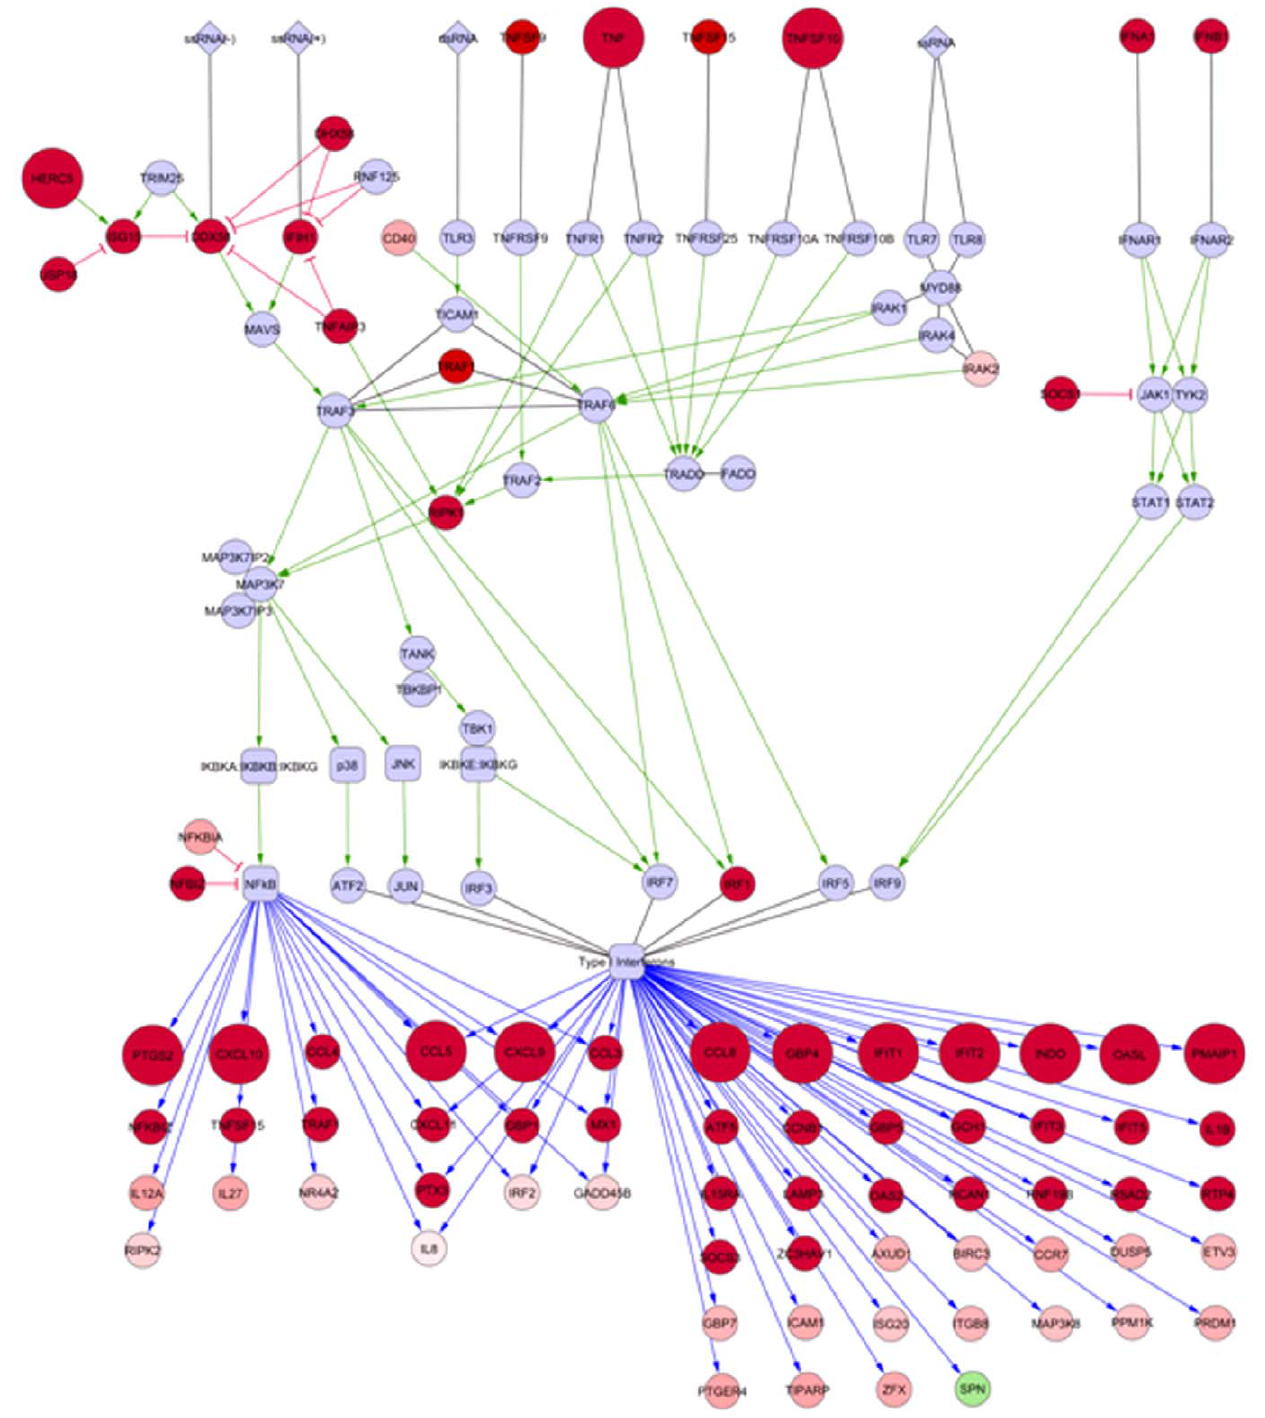
Figure 4. Components of the RIG-I, TNF and type I IFN pathways are up-regulated in response to H5N1 to greater extent than H1N1. Viral ligands are shown as diamonds, genes/proteins as circles, and complexes or pathways as rectangles. Green arrows indicate activation, red T-bars represent inhibition, black lines indicate binding, and blue lines indicate stimulation of gene expression. For clarity, blue lines feeding back to upstream pathway components were removed; many of these upstream components, however, are regulated by type I IFN and/or NF k B. The colour of a node reflected the H5N1:H1N1 expression ratio: blue nodes were not significantly differentially expressed in response to either virus, pink/red nodes were up-regulated more in response to H5N1 than H1N1 (red = . 1.5-fold more in response to H5N1, pink =1.0-1.49-fold higher in response to H5N1), and the green node was down-regulated to a greater extent in response to H5N1. Larger nodes had a fold-change value of . 10 in H5N1 infection.